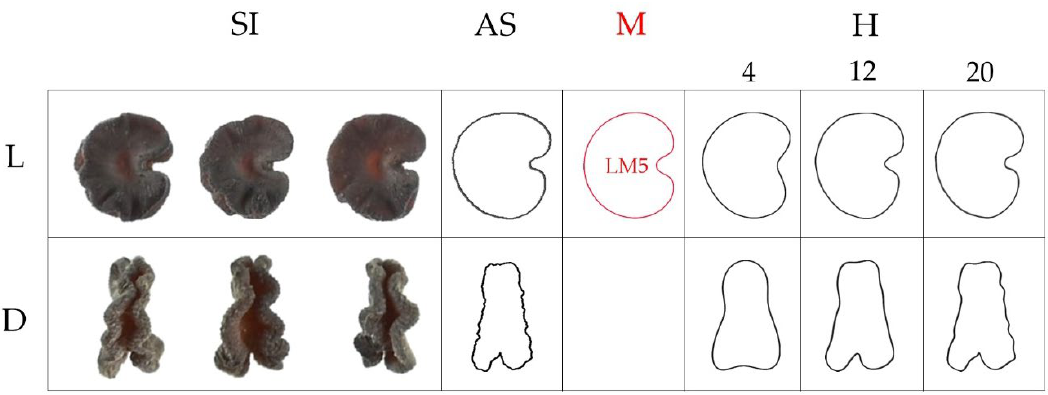
Figure 9. Silhouettes of seeds of S. apetala AJ283. L: Lateral view; D: Dorsal view; SI: Seed image; AS: Average silhouette of 20 seeds; M: Model calculated, LM5; H: Curves obtained by Fourier equations with 4, 12, and 20 harmonics.